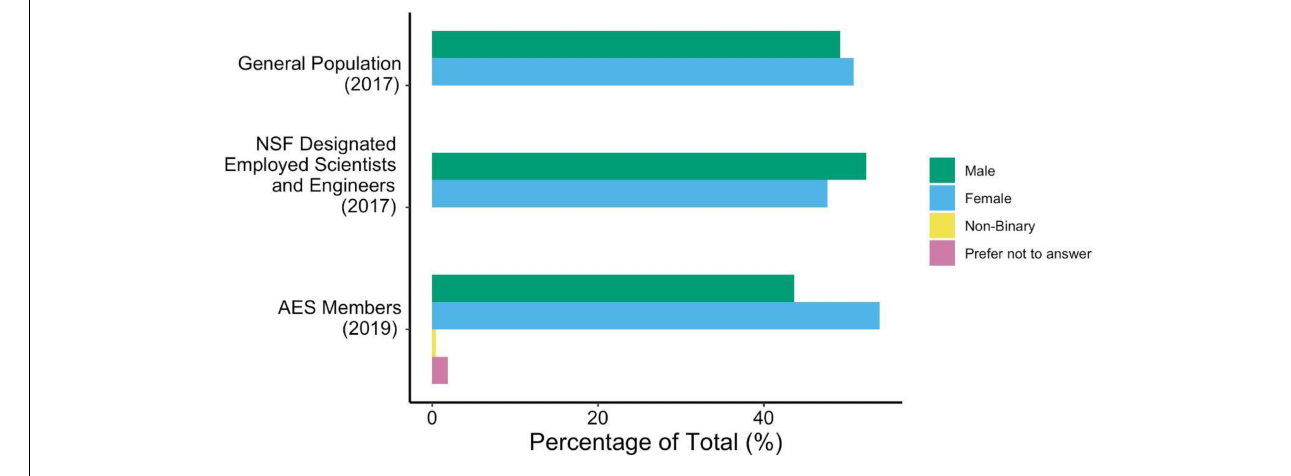
FIGURE 2 | Gender of AES members compared with National Science Foundation statistics.